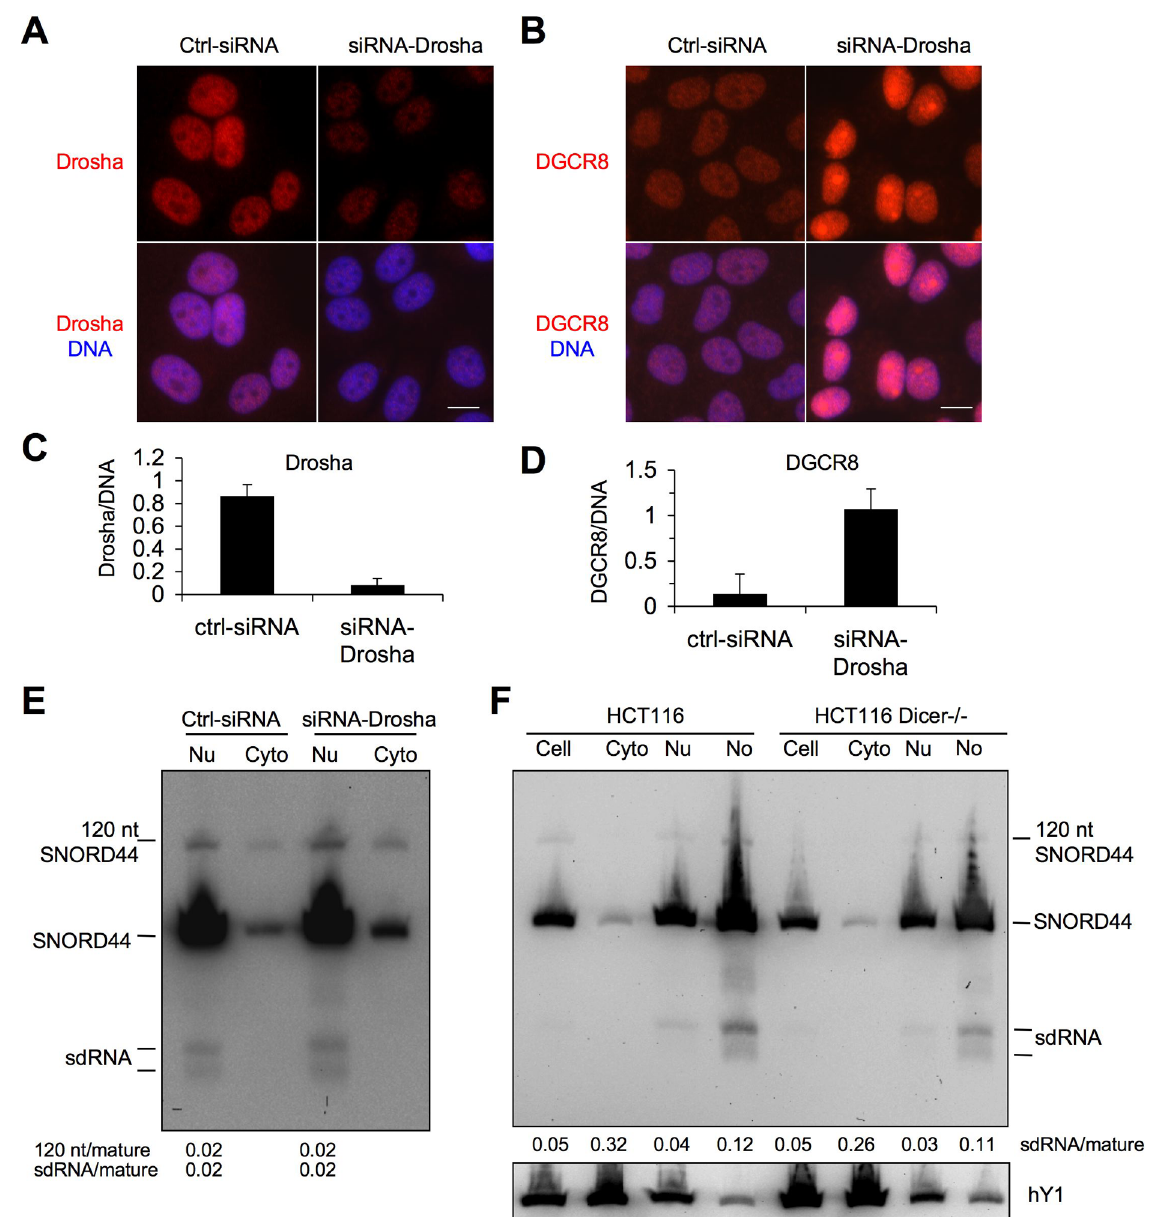
Figure 5. The canonical siRNA-processing pathway is not involved in the regulation of SNORD44 sdRNAs. A–D HeLa cells were transfected with control or Drosha-targeting siRNA and incubated for 48 hours. Cells were fixed and stained for Drosha ( A ) or DGCR8 ( B ), and counterstained for DNA. Merged images are shown. Scale bar, 10 m m. ( C, D ) Image quantifications for ( C ) Drosha and ( D ) DCGR8. Mean normalized fold intensity is shown. Error bars, SD. E Nuclear (containing nucleoli) and cytoplasmic fractions were prepared of the cells described in A, and RNA was isolated. Northern hybridization was conducted using the SNORD44 5 9 probe. Signal intensities for 120 nt and sdRNAs were quantified and normalized against the mature SNORD44. F HCT116 and HCT116 Dicer 2 / 2 cells were subjected to subcellular fractionation, RNA was isolated and Northern hybridization was conducted using the SNORD44 5 9 probe. Signal intensities for sdRNAs normalized to mature SNORD44 are provided below. hY1 probe was used as